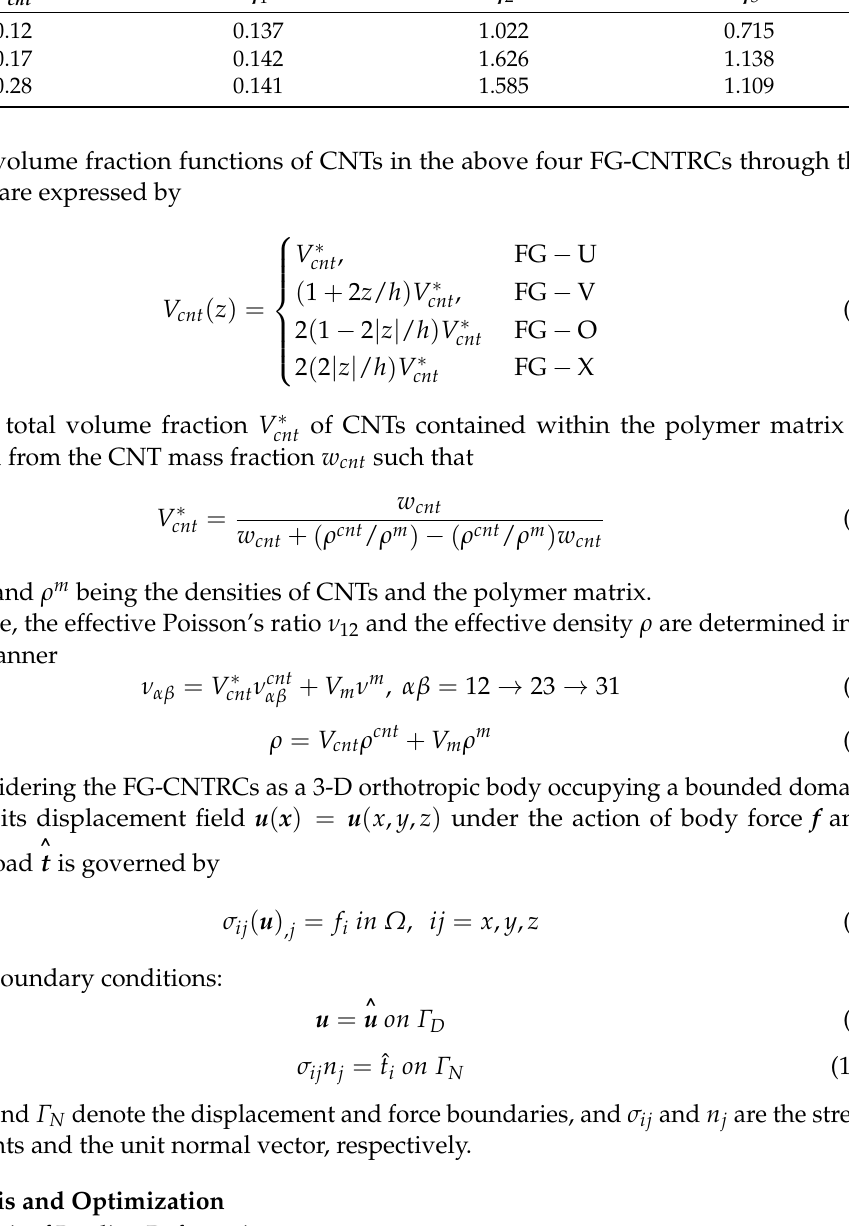
T = 300 K ). Table 1. The CNT efficiency parameters for three different V ∗ cnt (PMMA/CNT at V * cnt η 1 η 2 η 3 0.12 0.137 1.022 0.715 0.17 0.142 1.626 1.138 0.28 0.141 1.585